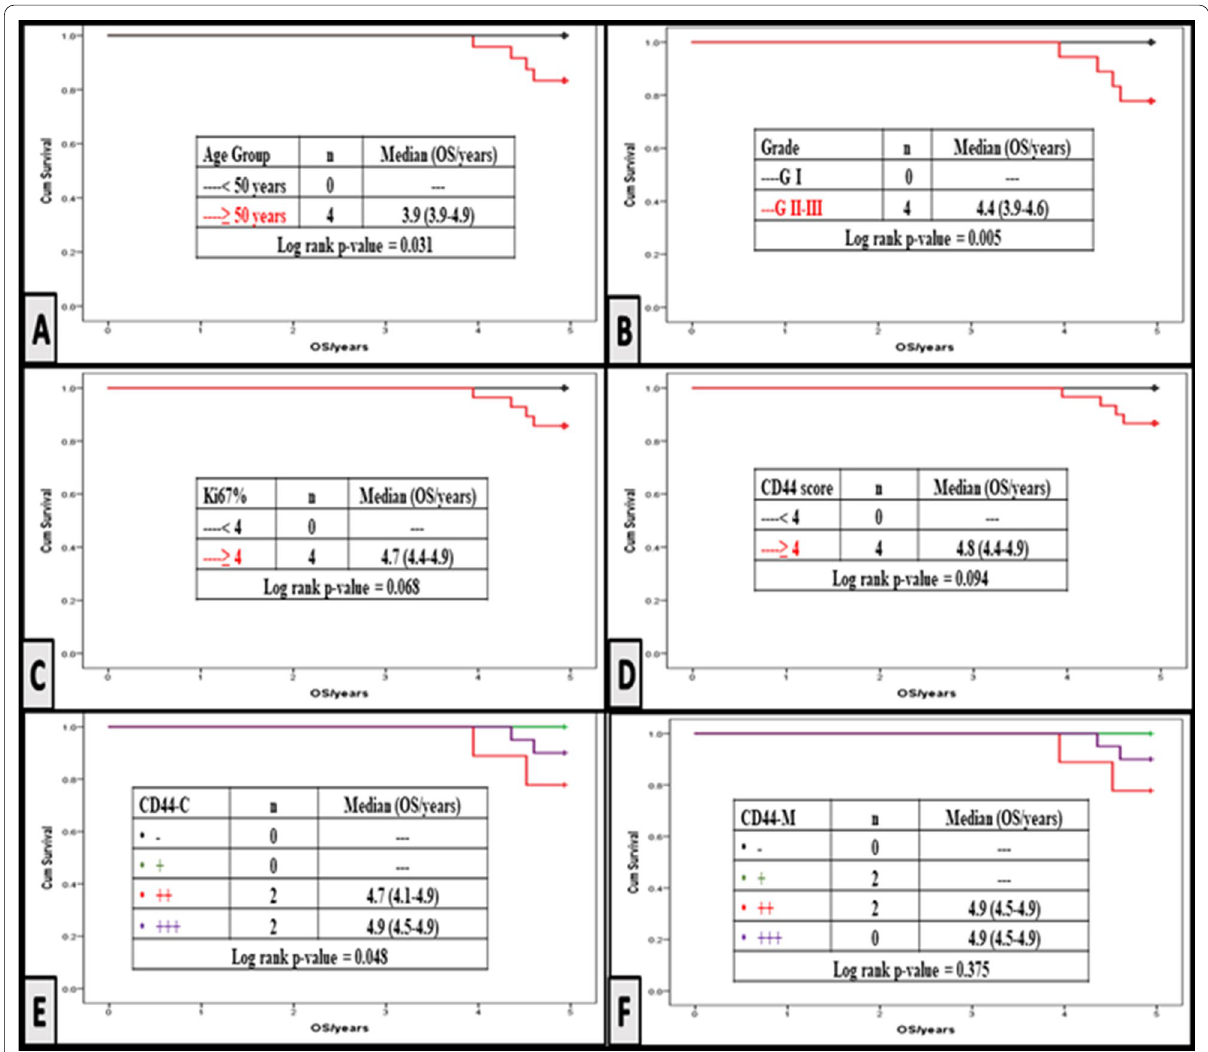
Fig. 4 Kaplan–Meier survival curves for the effect each factor on overall survival: A Age, B Grade, C Ki67%, D CD44 Score, E CD44-C and F CD44-M. OS overall